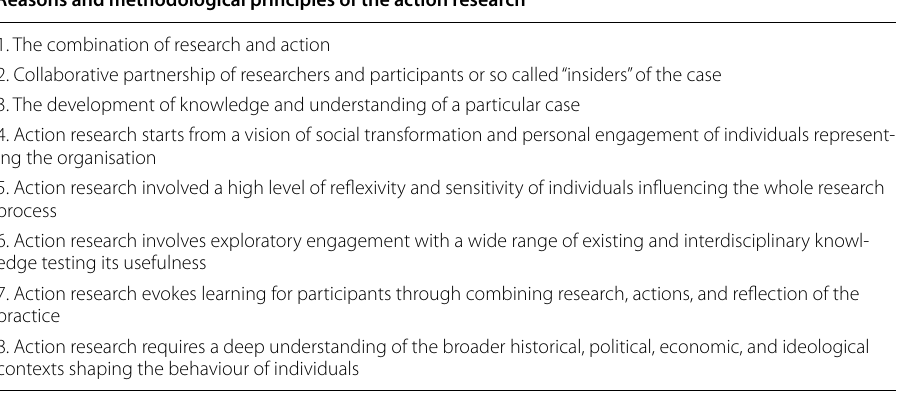
Table 3 Methodological principles of the action research applied within this study. Source: developed by the authors based on Somekh